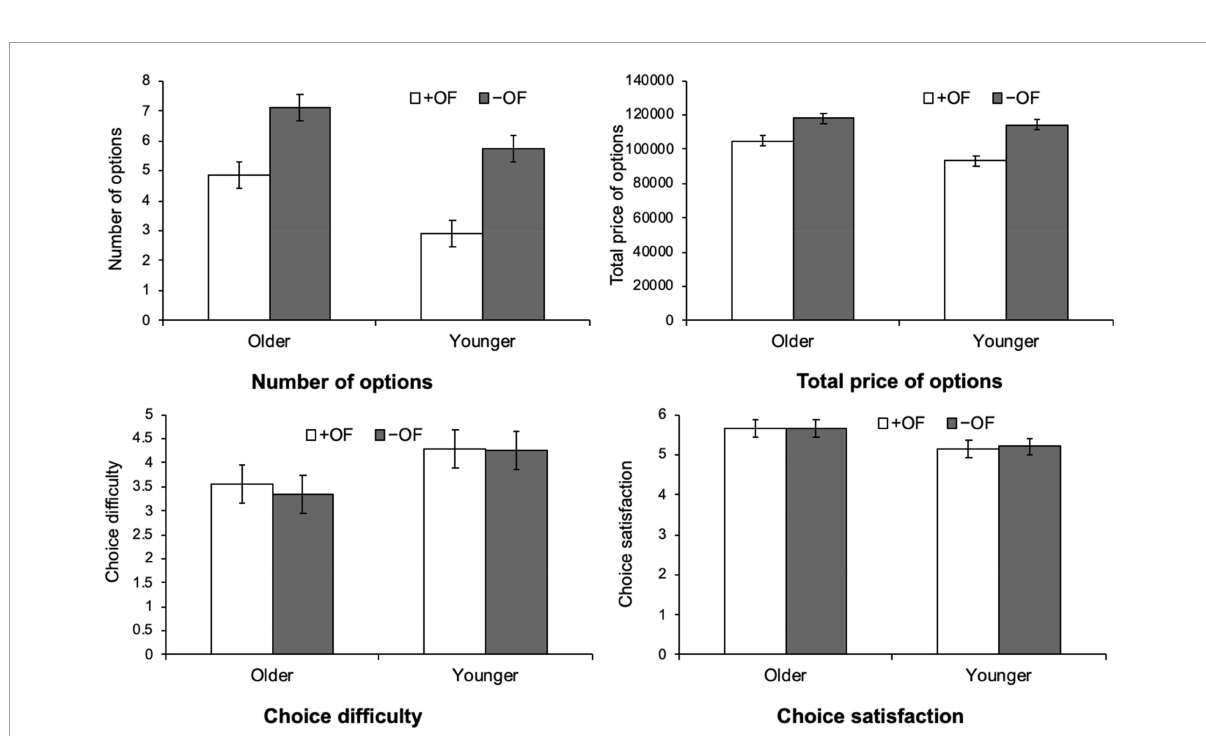
FIGURE2 Age differences in the effects of framing on the number of options chosen, total price, choice difficulty, and choice satisfaction for the medical